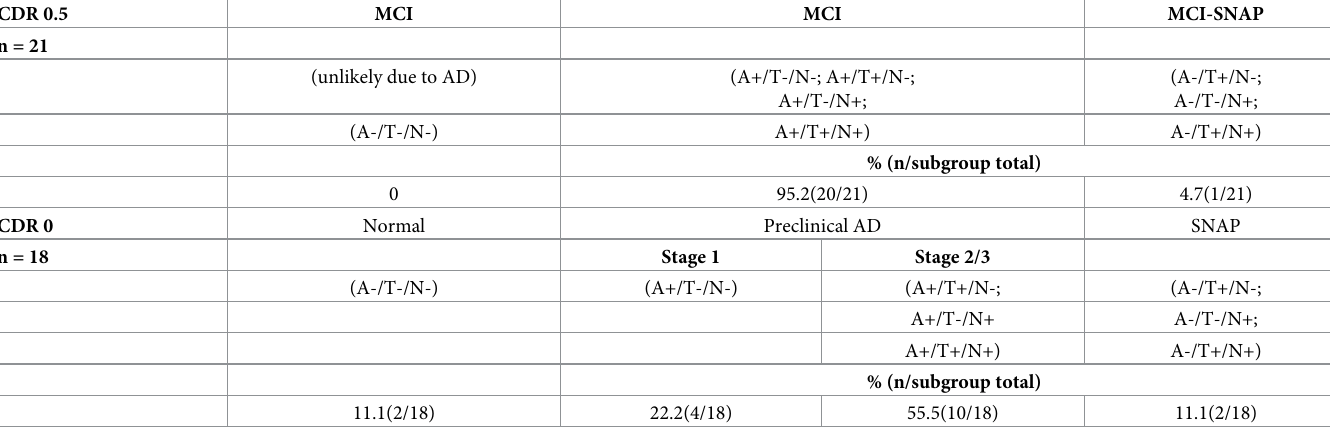
Table 5. CSF biomarker profiles of HFR patients without dementia (CDR = 0 and 0.5) were categorized according to the A/T/N and corresponding NIA-AA classification system. The vast majority of patients had CSF biomarkers suggestive of preclinical AD. In the CDR = 0.5 group, 95.2% (20/21) of patients had abnormal CSF biomarker levels. The remaining patient was categorized as Suspected Non-Alzheimer’s Pathology (SNAP). In the CDR = 0 group, 11.1% (2/18) samples had normal biomarker levels, while 77.7% (14/18) of patients had abnormal biomarker levels. Cutoff values for each biomarker level considered are as follows: CSF A β